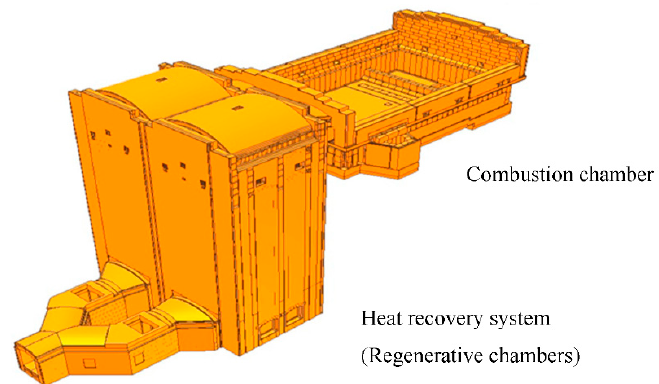
Figure 1. Regenerative End-Port glass production furnace.